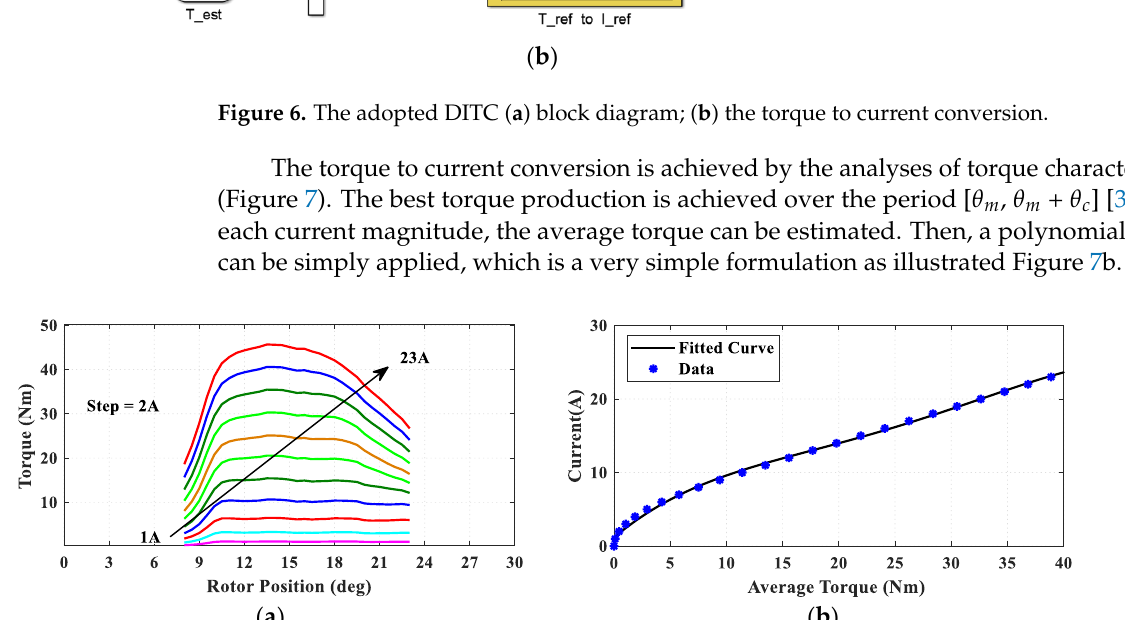
Figure 6. The adopted DITC ( a ) block diagram; ( b ) the torque to current conversion.